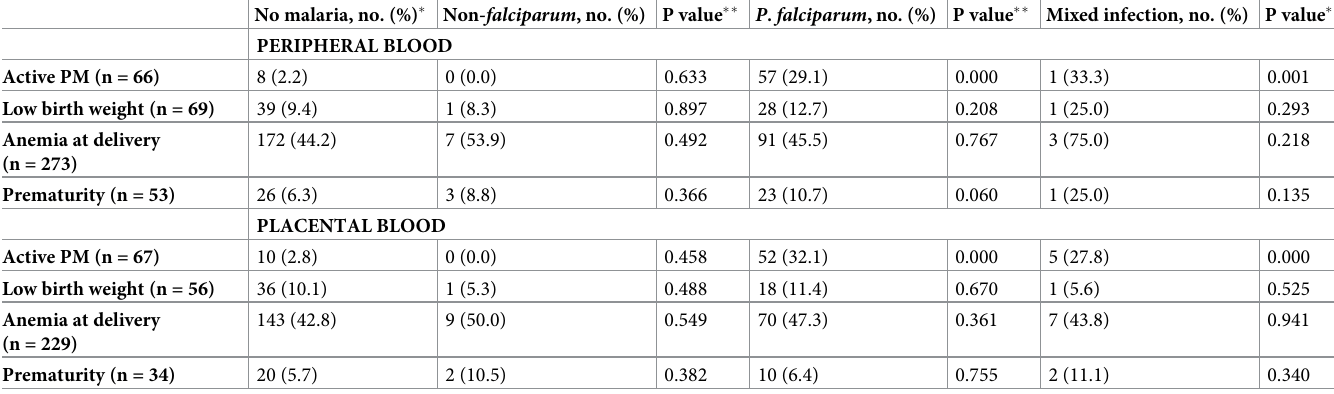
Table 8. Association of Plasmodium spp. infections at delivery with pregnancy outcomes.